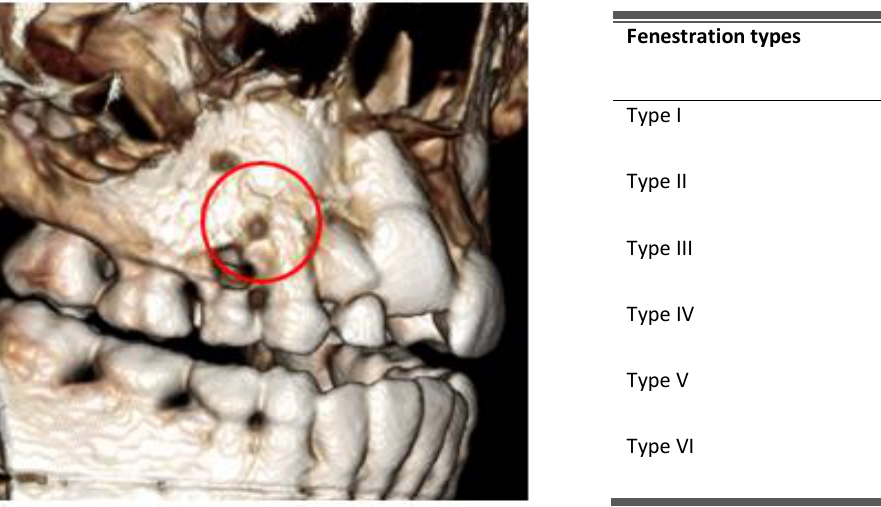
Figure 4. Presence of fenestration - Type IV.